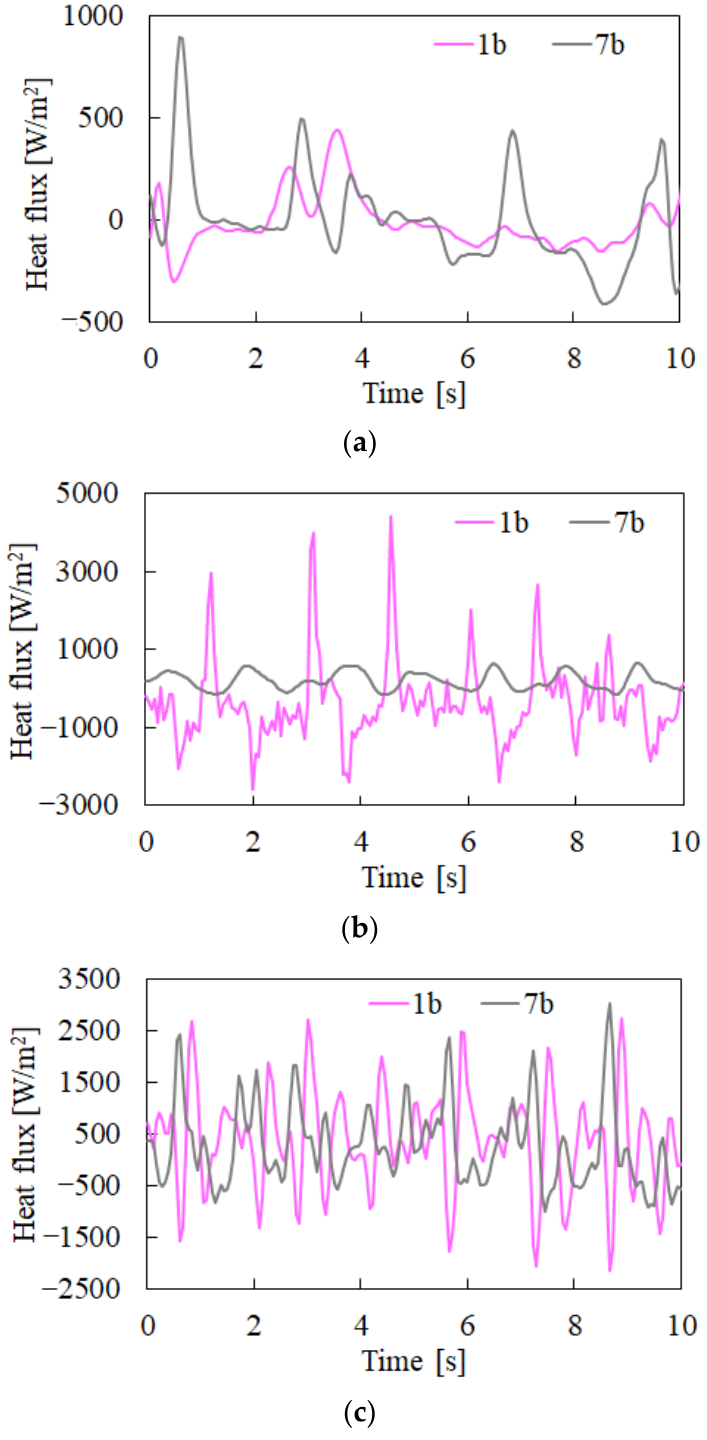
Figure 10. Heat fluxes at 1b and 7b: ( a ) Q ele = 0.5 W, ( b ) Q ele = 2 W, ( c ) Q ele = 3.5 W.